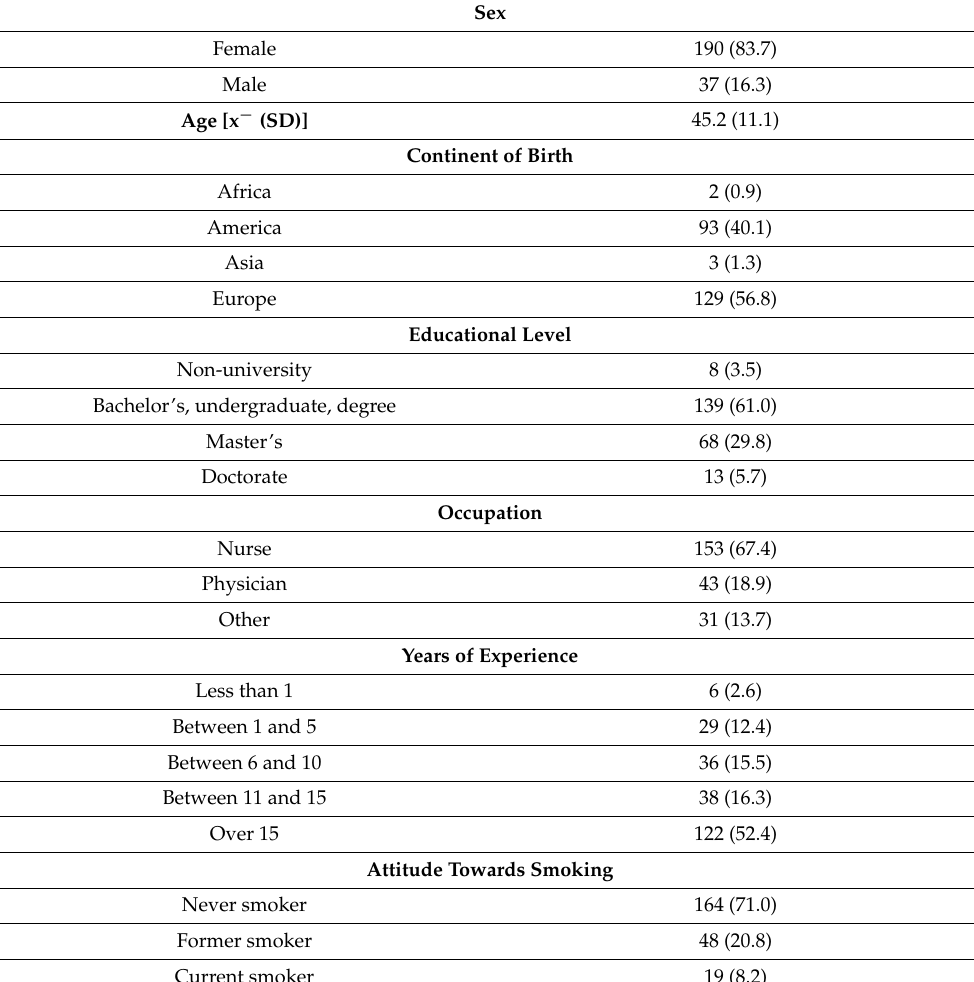
Table 1. Sample characteristics (n = 233).